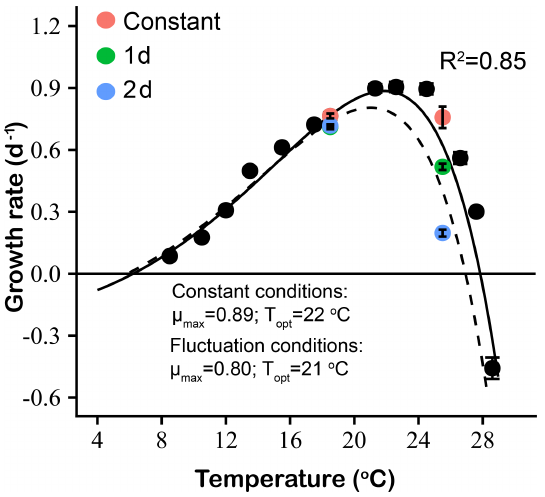
Figure 8. Thermal performance curves based on specific growth rates (d − 1 ) of Emiliania huxleyi , including our experimentally de- termined constant condition temperature performance curve (black symbols and solid line) and a predicted fluctuating condition tem- perature performance curve (dashed line) according to the model of Bernhardt et al. (2018). Measured growth rates from the two low- and high-temperature experiments are shown for constant thermal conditions (red symbols), 1d (green symbols) and 2d (blue sym- bols) variation